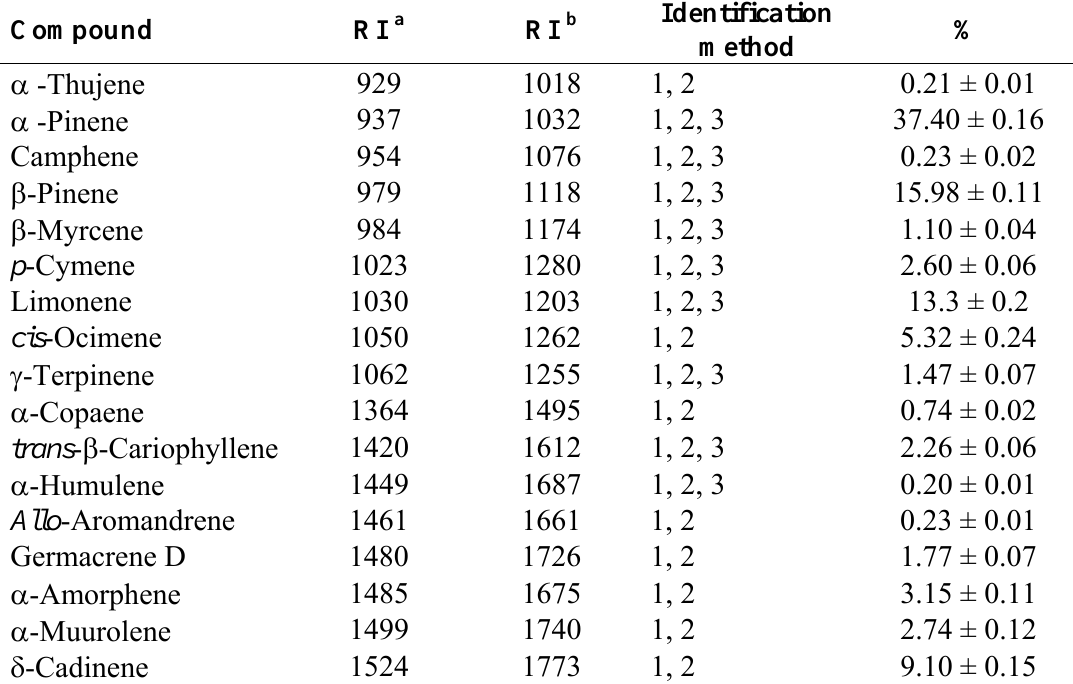
Table 1. Chemical composition of R. anthopogon essential oil.